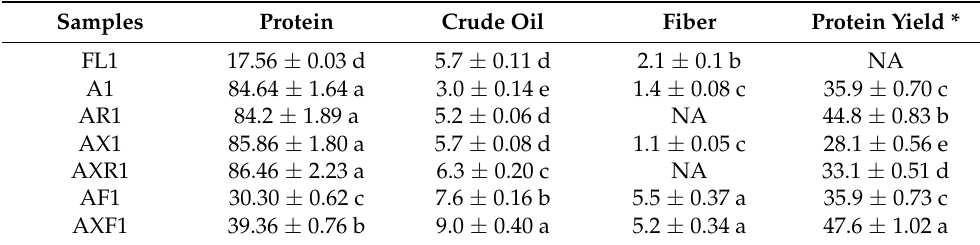
Table 1. Chemical characterization of oat protein concentrates, g/100 g in DM. Different letters within a column indicate significant differences for each parameter ( p < 0.05).